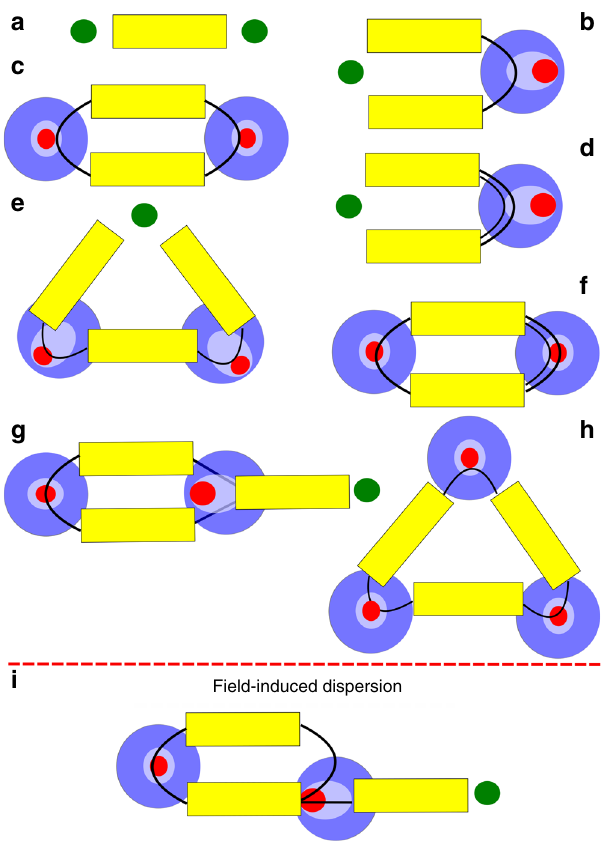
Fig. 2 Diagrammatic expansion of interacting quantum Drude oscillators. Representative low-order interaction energy diagrams for coupled QDOs, associated with the following expansion terms: a bare Coulomb electrostatic interaction; b dipole polarization; c conventional vdW dipole – dipole dispersion; d quadrupole polarization; e many-body dipole polarization; f dipole – quadrupole dispersion; g dipole – quadrupole electrostatic interaction; h three-body dipole – dipole-dipole dispersion; i charge-induced pairwise dipole – quadrupole dispersion (called FID in this paper). QDOs are sketched by blue circles with red oscillation center and the external charge is shown with a green dot, polarization is indicated with elongation of the inner